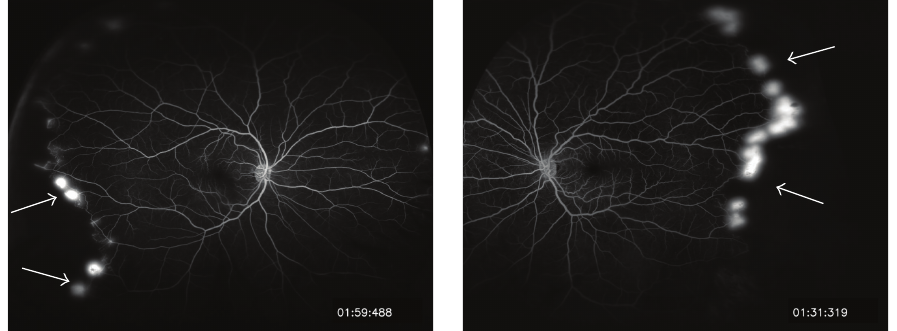
Figure 2: Fluorescein angiography of both eyes showing peripheral neovascularization with leakage (white arrows) and capillary nonperfu-